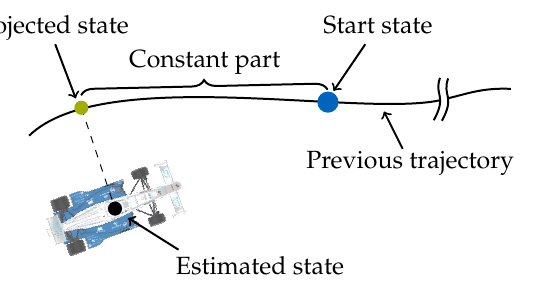
Figure 4. The start state of the trajectory generation is determined by projecting the estimated state onto the previously planned trajectory and keeping constant the part corresponding to the average planning calculation